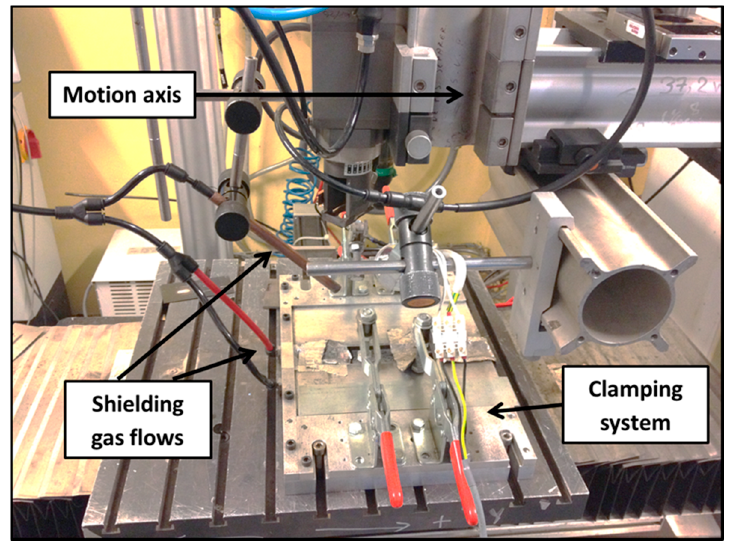
Figure 1. Experimental devices.